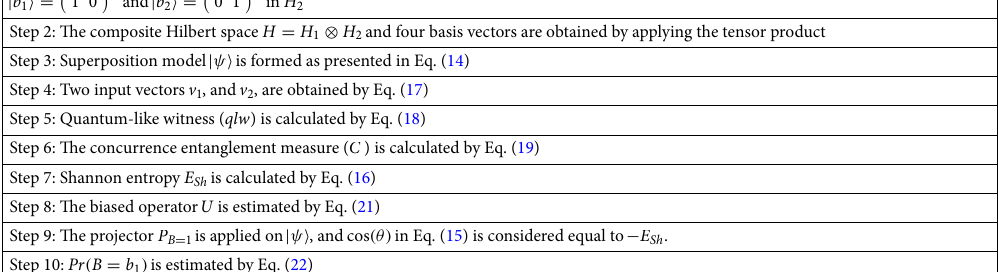
Table 3. The Pseudo-code of the BEQBN model for a binary decision-making problem.